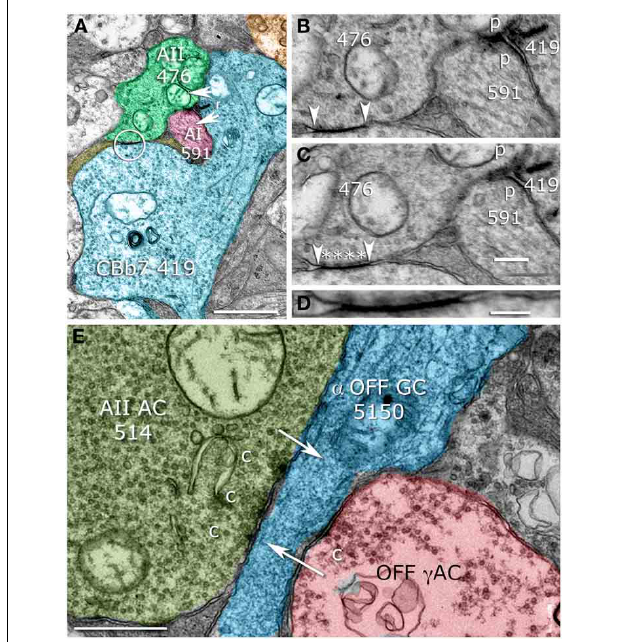
FIGURE 9 | Sparse AII cell contacts. (A) CBb7 419 forming both ribbon synapses (r) and a gap junction (circle) with AII cell 476. CBb7 419 also contacts AI cell 591. (B,C) Serial sections through the ribbon synapse and its postsynaptic targets (p) and the gap junction (arrowheads) with characteristic AII cell cytoplasmic densities (Anderson et al., 2011b), asterisks. (D) Maximal resolution image of the gap junction showing apparent membrane fusion. (E) AII cell 514 making a multi-projection conventional presynaptic specialization (c) targeting OFF ganglion cell 5150 (arrow). Scales (A,E) 500nm; (C) 250nm, (D) 100nm. (B–D) Were contrast adjusted to γ = 1 . 5 to discriminate gap junction membranes and